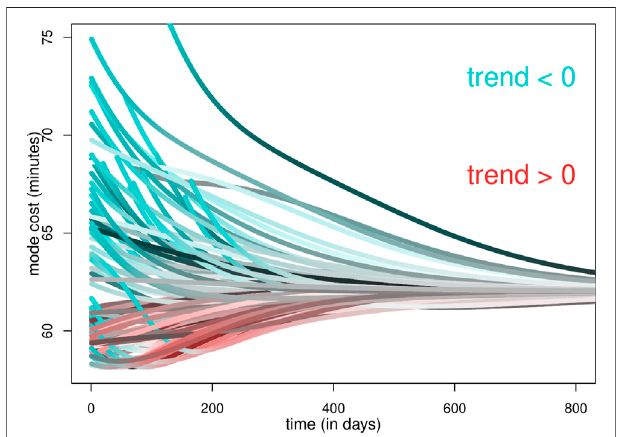
FIGURE 4 | Mean commuting time in minutes (vertical axis) for different initial conditions μ x 0 ( t ) as time evolves (horizontal axis) measured in some dimensionless time scale, marked as “ days ” . All initial conditions converge to the same average commuting time (approximately 62 min). Distinct curves are identi fi ed by their shade. When a trajectory increases its commuting time, it is shaded in red, and when it is decreasing its commuting time, it is coloured in blue. Some of the trajectories have, at some point, lower commuting time, but they have some tragic regions where the average commuting time is